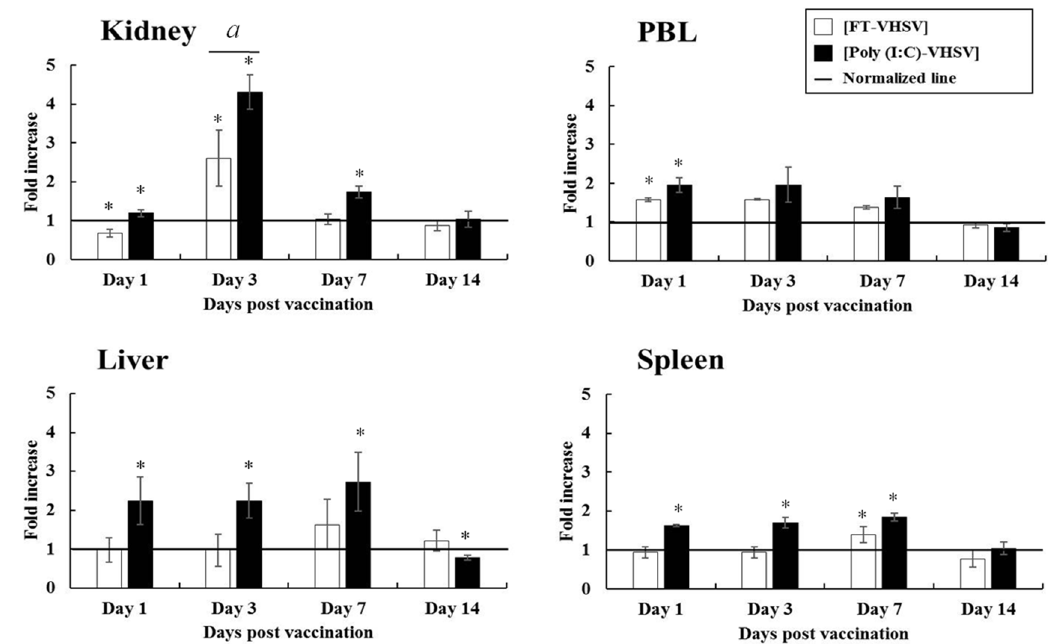
Figure 6. Fold increase in CD3 + T cell populations in olive flounder after poly (I:C) potentiated and formalin-treated VHSV vaccination determined by flow cytometry. Leukocytes were isolated at 1, 3, 7, and 14 dpv from the kidney, liver, spleen and PBL for three fish from both the Poly (I:C)-VHSV ( n = 30) and the FT-VHSV ( n = 30) groups. The CD3 + T cell response was observed and presented as a fold increase compared to the T cell population in the negative control group (adjusted to 1 and shown by a solid line). Error bars indicate the standard deviation of the mean. Asterisks (*) represent a significant difference between each experimental group and the negative control group by one-way ANOVA ( p < 0.05). Symbol ( a ) indicates a statistical difference between the FT-VHSV and Poly (I:C)-VHSV groups by one-way ANOVA at a particular time point ( p < 0.05).